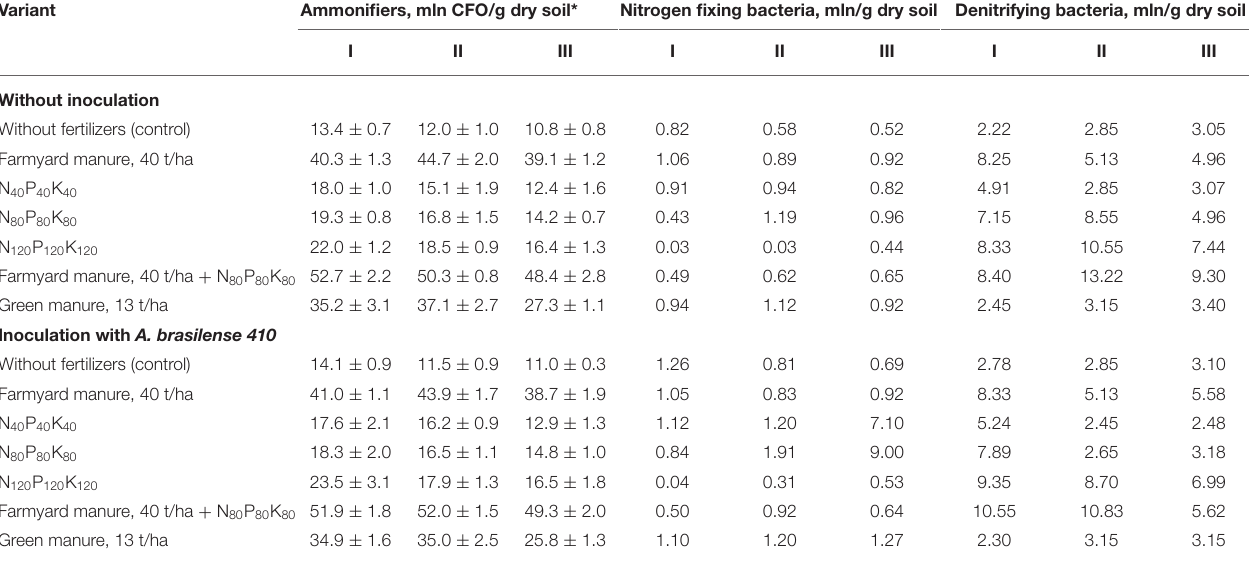
TABLE 2 | The quantitative dynamics of ammonifiers, nitrogen fixing microorganisms and denitrifying bacteria in the rhizosphere soil of potato plants under the action of fertilizers and inoculation (2018).